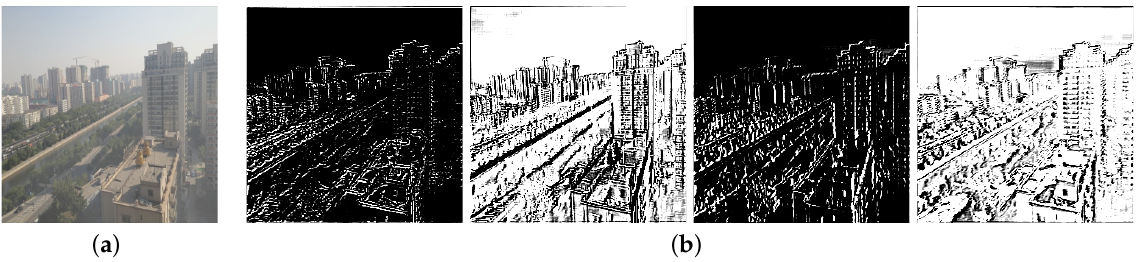
Figure 4. Samples of feature maps: ( a ) input image; ( b ) feature maps extracted from ( a